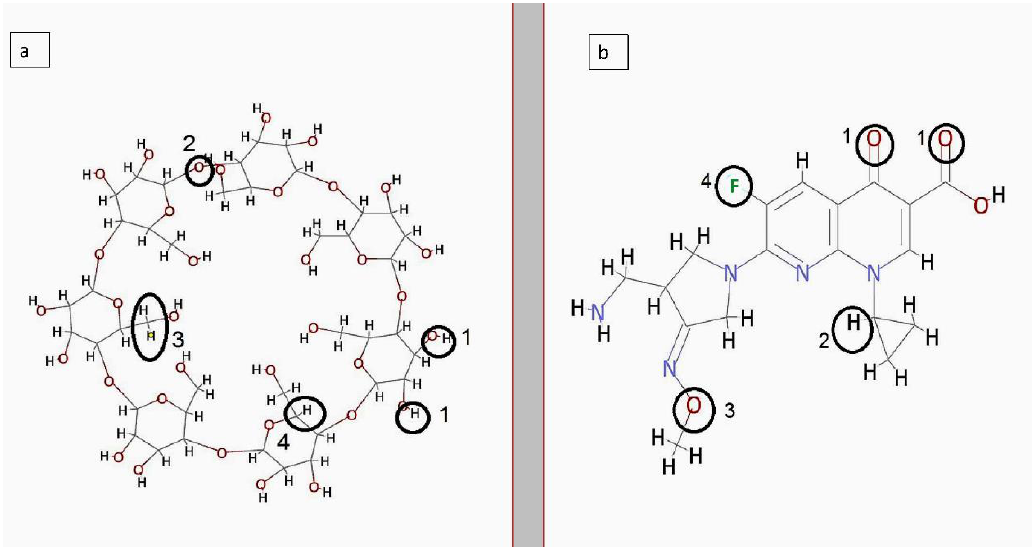
Figure 5. Two-dimensional interactions showing atoms and groups involved in hydrogen bonding between molecules of ( a ) host and ( b ) guest.